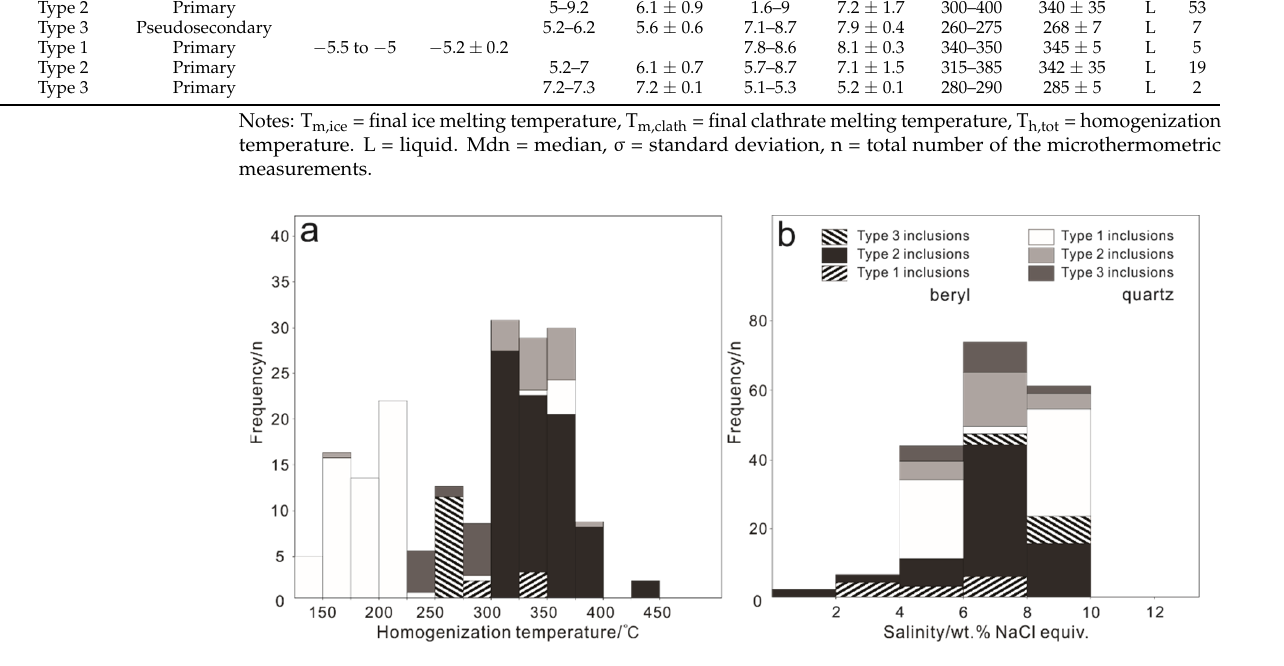
Figure 9. Frequency distribution of ( a ) total homogenization temperature; ( b ) salinity.